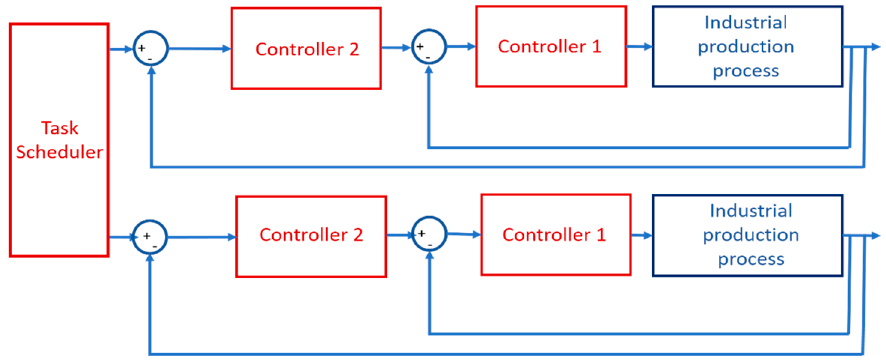
Figure 2. Self-optimizing production system control framework.